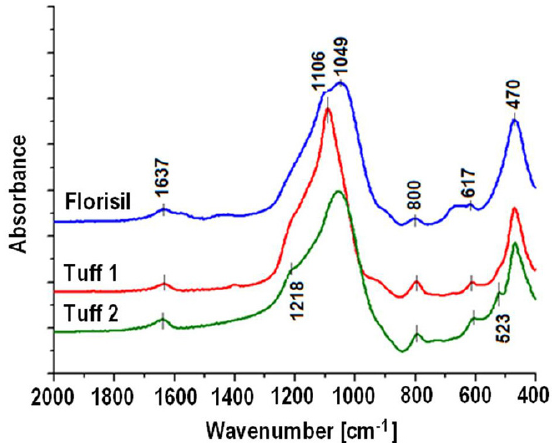
Figure 5. FTIR spectra of the studied